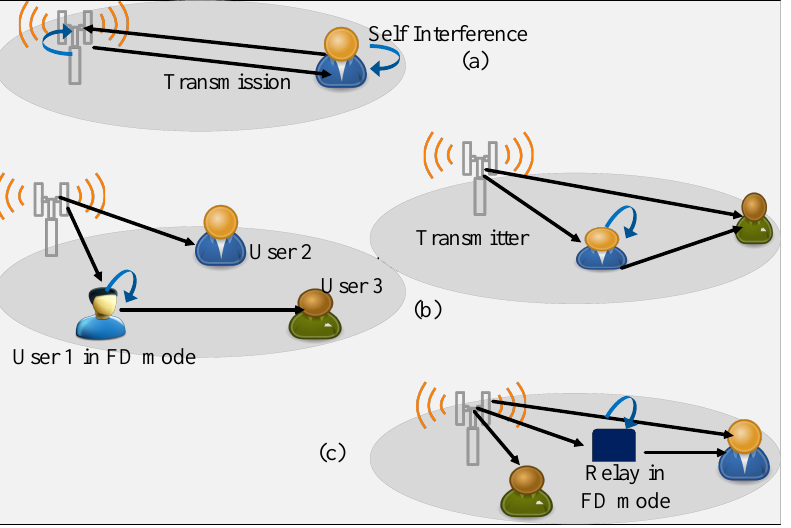
Figure 1. Three different ways of combining FD with NOMA. ( a ) When transmission is in both downlink and uplink. ( b ) D2D communication with a direct and no direct link between transmitter and the distant user. ( c ) The use of a FD mode relay for assisting the distant user. IBFD and D2D communication have common characteristics including better perfor- mance at short distances and reduced self-interference at low power transmit signals